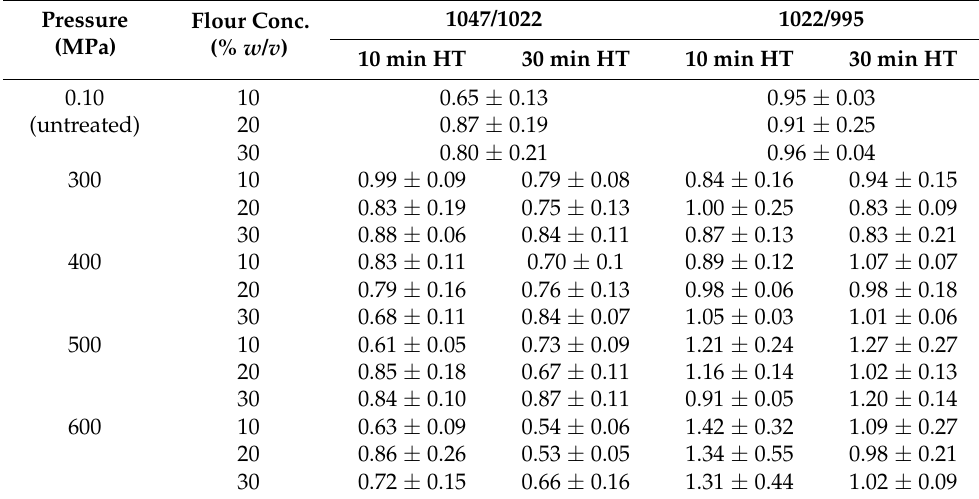
Table 3. Absorbance ratio values of untreated and HPP-treated cassava flours.